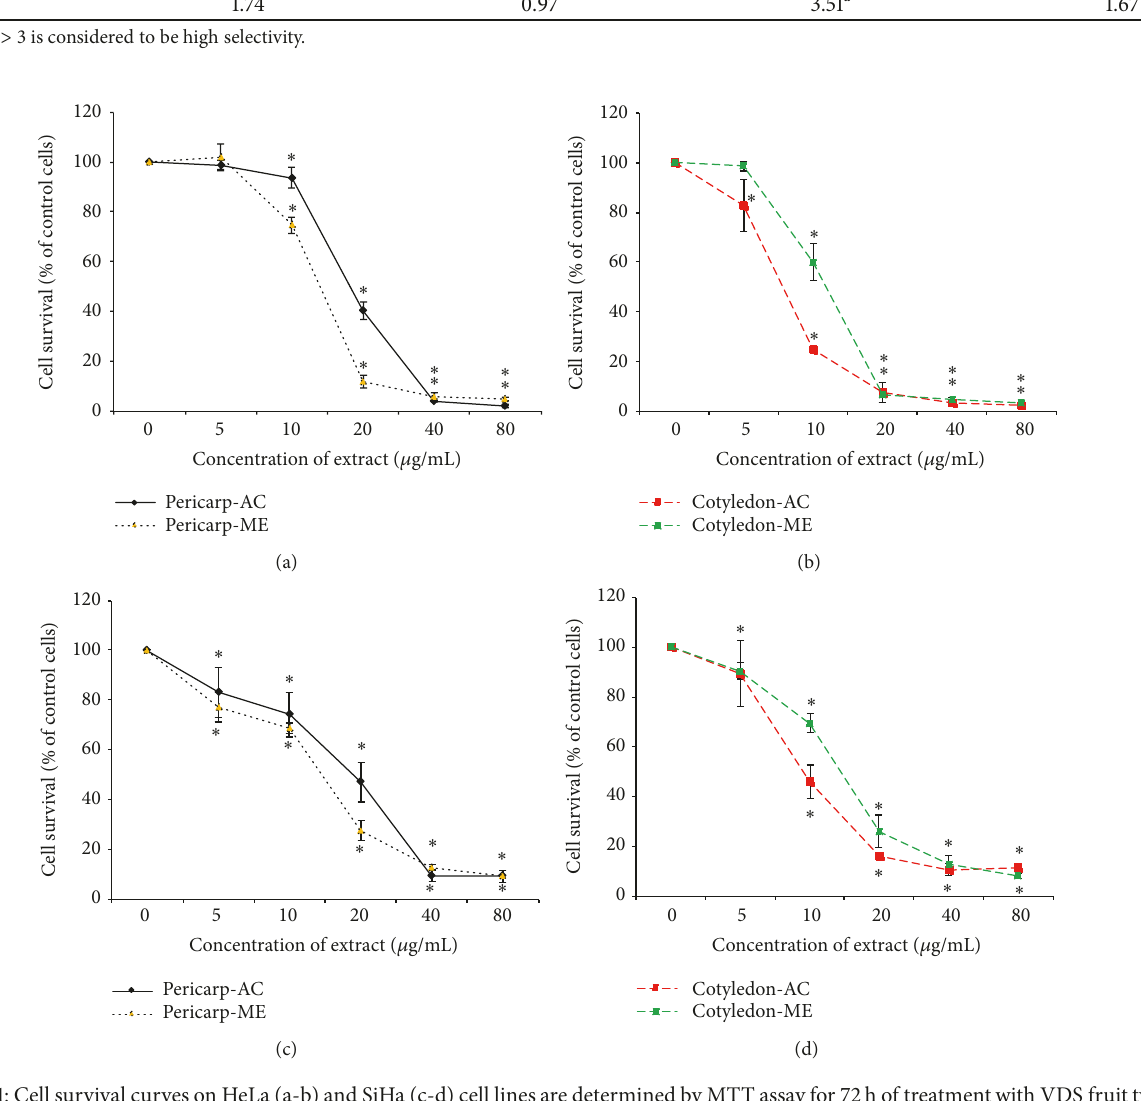
Figure 1: Cell survival curves on HeLa (a-b) and SiHa (c-d) cell lines are determined by MTT assay for 72h of treatment with VDS fruit type SS crude extracts with concentrations of 0, 5, 10, 20, 40, and 80 𝜇 g/mL (ME, methanol, and AC, acetone). Data are shown as mean ± SD of three independent experiments ( ∗ p < 0.05; the mean difference is significant at the 0.05 level compared to control by one-way